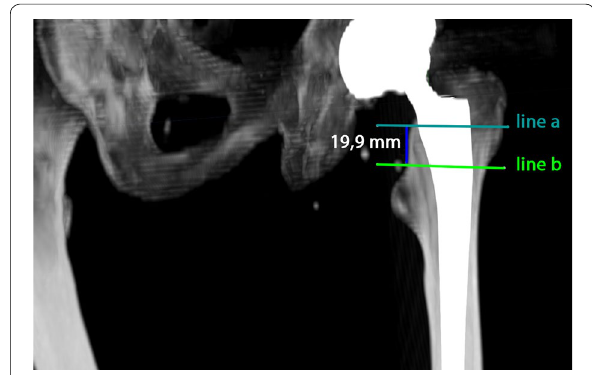
Fig. 2 Measurement of femoral neck resection height. Line a represents the deepest point of the resection line and line b the proximal basis of the lesser trochanter